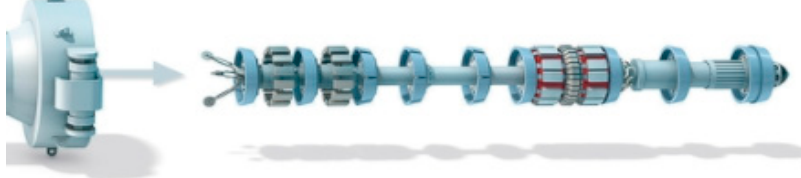
Figure 3. PIG with odometers and transmitter.